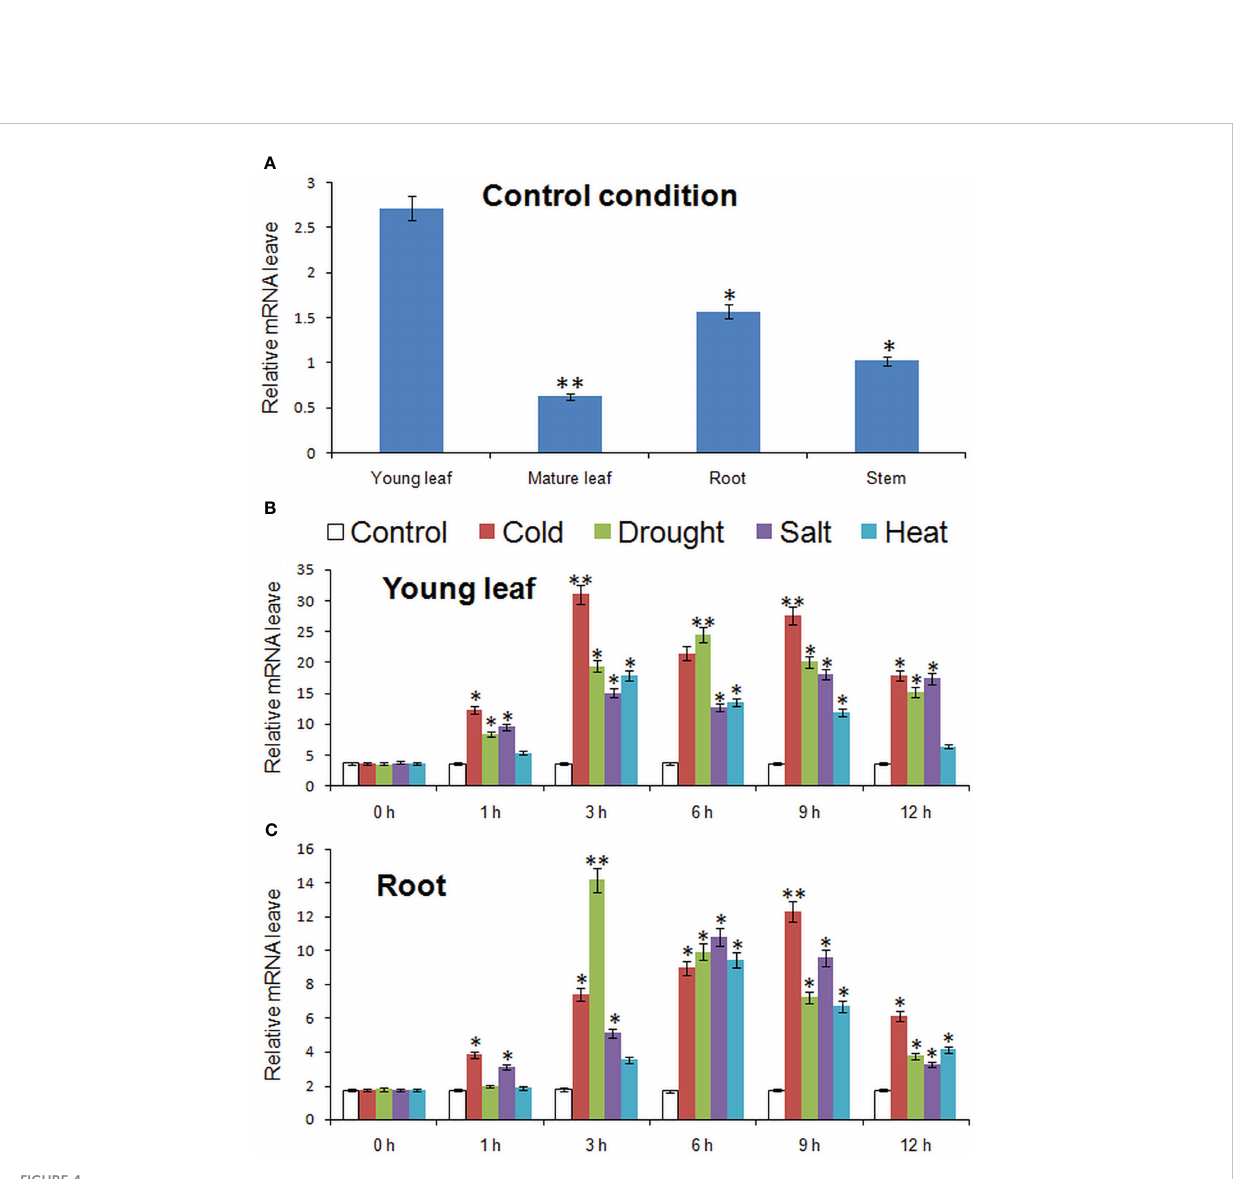
FIGURE 4 Results of qPCR analysis of MbMYBC1 . (A) The expression of MbMYBC1 in different parts of in M. baccata ; The expression of MbMYBC1 in new leaves (B) and roots (C) under different stresses. Compared with the Control, the asterisks above the column indicate signi fi cant difference and extremely signi fi cant difference (*, p ≤ 0.05; **, p ≤